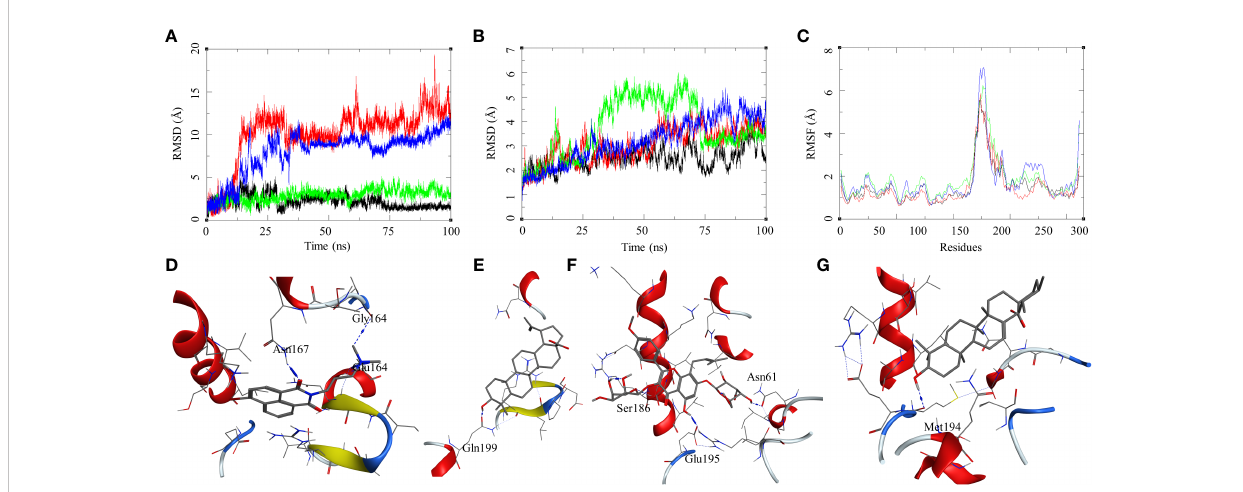
FIGURE 6 Molecular dynamics simulation results for M. tuberculosis dormancy survival regulator (DosR) (PDB: 3C3W): (A) ligand RMSD for HC104A (black), BA (red), IC (green), and UA (blue); (B) ligand-bound protein RMSD for HC104A (black), BA (red), IC (green), and UA (blue); (C) ligand-bound protein RMSF for HC104A (black), BA (Red), IC (green), and UA (blue). Protein – ligand complex poses at the end of the 100-ns simulations, (D) DosR – HC104A, (E) DosR – BA, (F) DosR – IC, and (G) DosR –